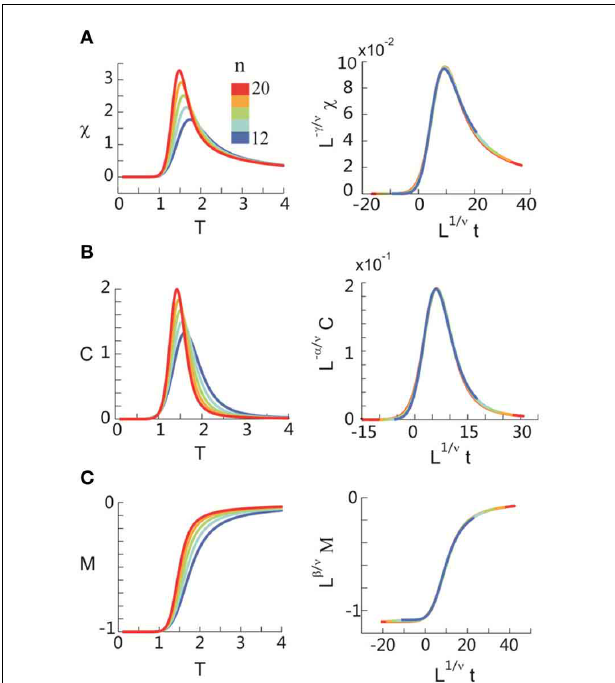
FIGURE 3 | Stability of the power law size distribution during the recording. (A) Avalanche pattern size distribution of the whole recording (30min) plotted in a double-logarithmic scale. ε , exponent of the best fitting power law to the distribution. Avalanche pattern was identified based on the activities recorded in the whole array (91 channels, Monkey 1). (B) The full dataset as analyzed in (A) was split into 10 consecutive, non-overlapping segments, each of which lasted for 3min.